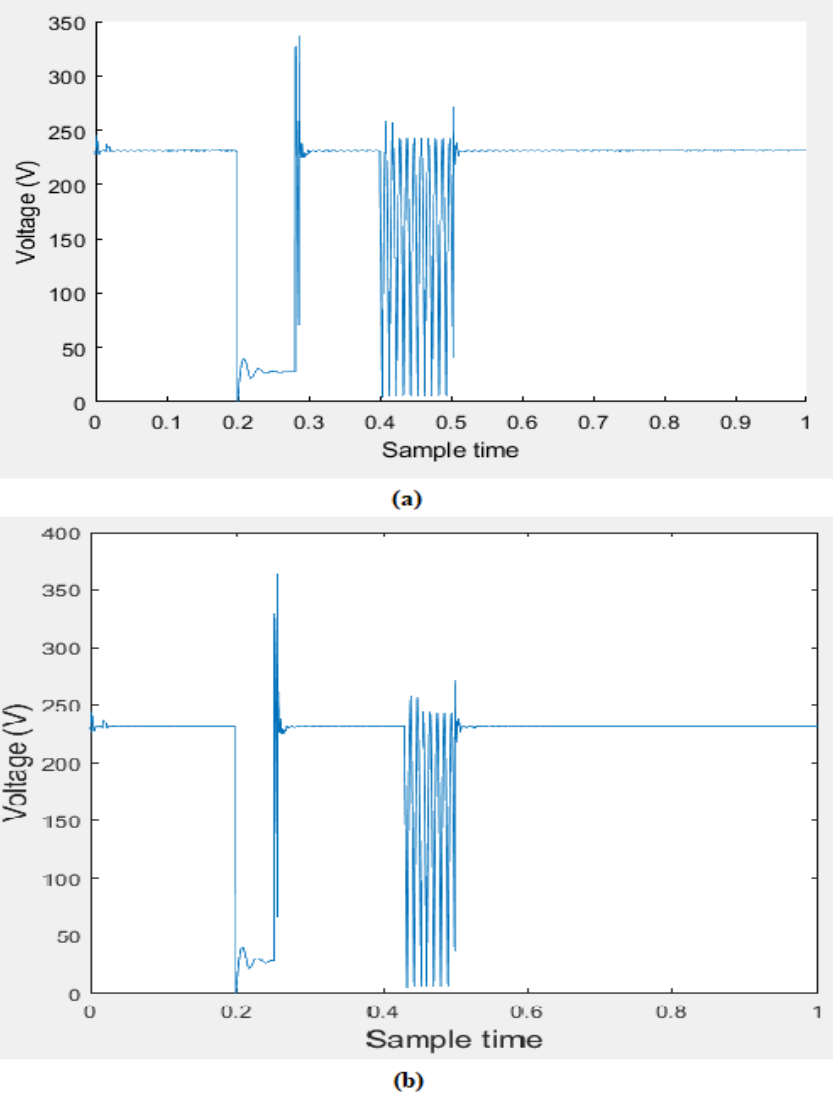
Figure 7. RMS Voltage signal at bus 3: ( a ) MG 1 , ( b ) MG 2